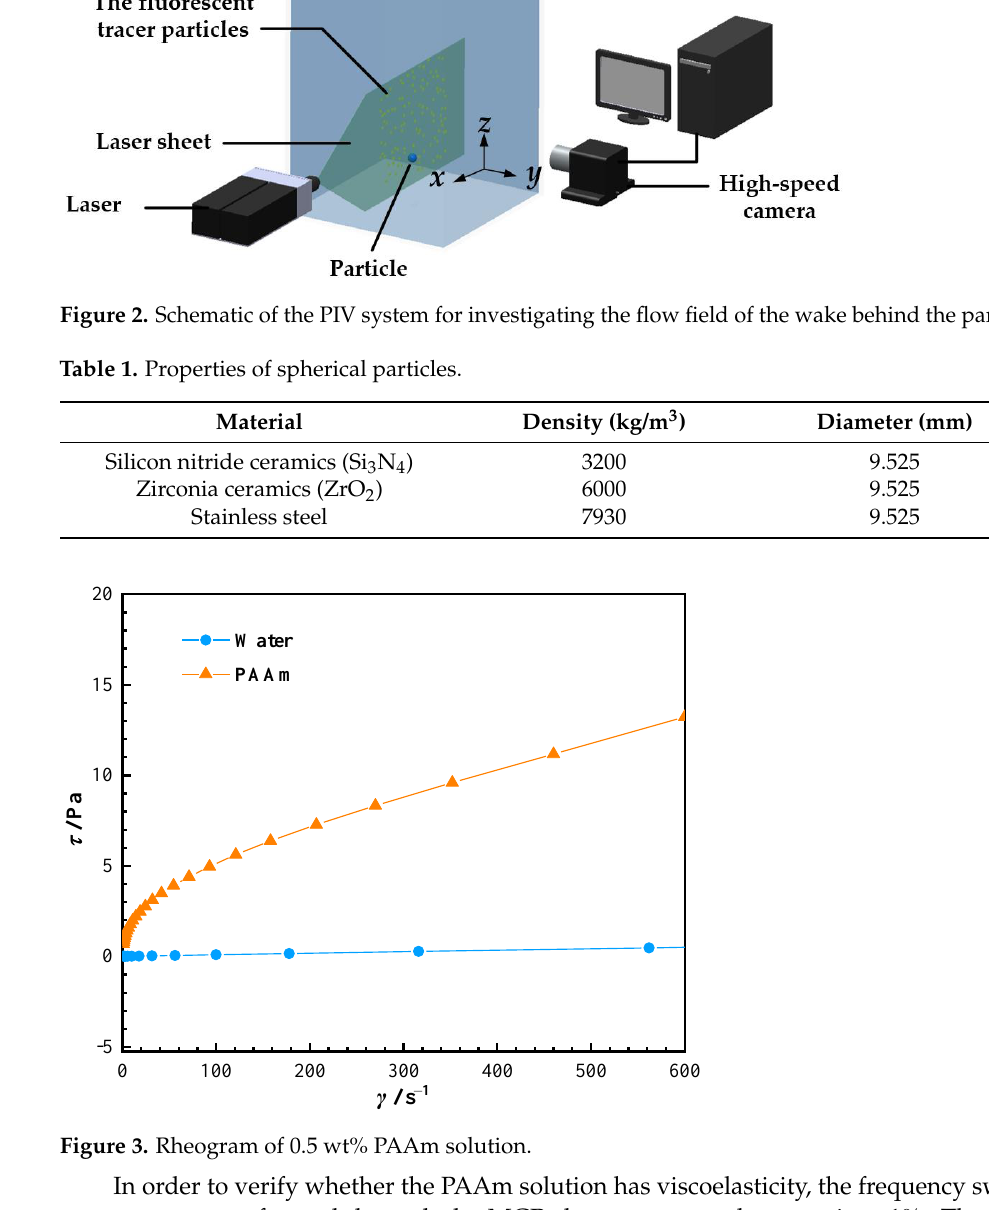
Figure 1. Schematic of the experimental setup for two side-by-side particles settling.